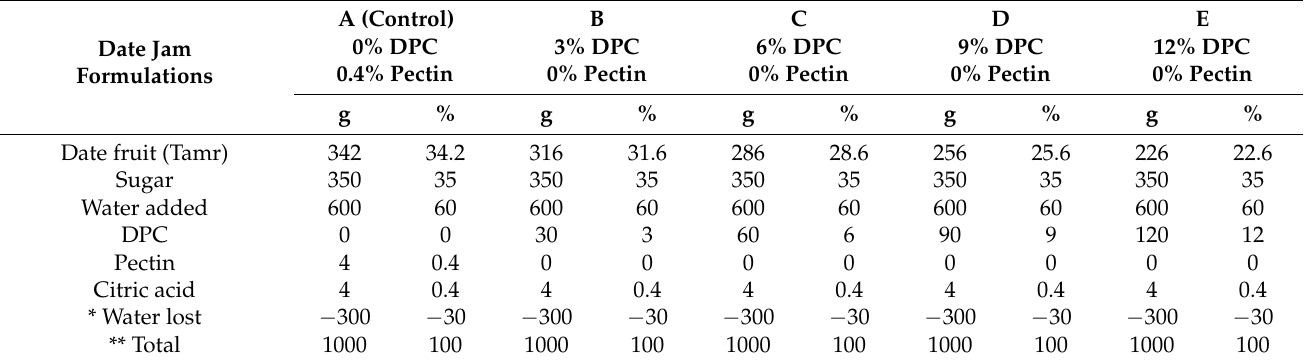
Table 2. Formulation of date jam treatments with gradient quantity of date press cake